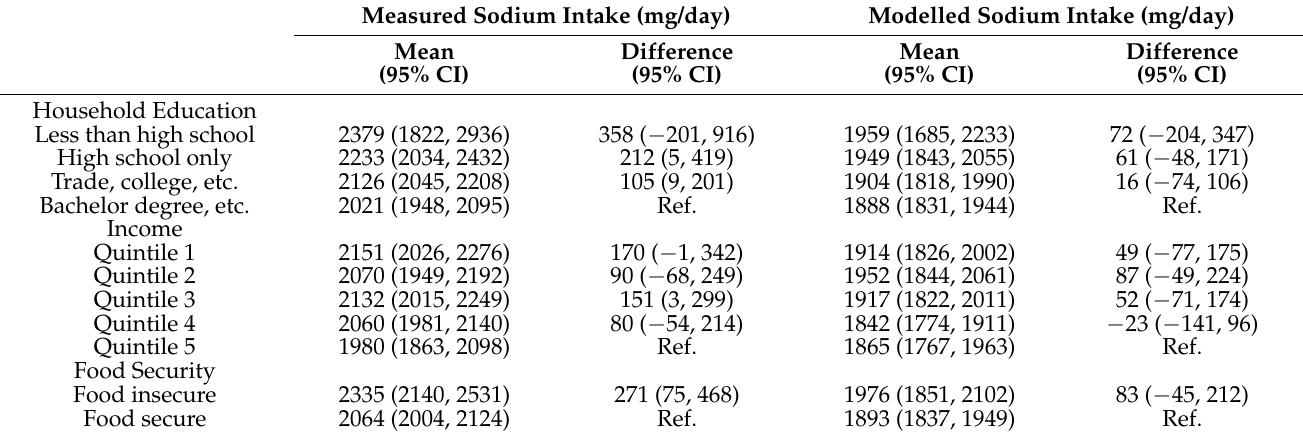
Table 2. Adjusted mean sodium intake and mean differences by socioeconomic position as measured and modelled full compliance to Health Canada’s voluntary Sodium Reduction Guidance (SRG) targets in children 2 to 8 years old in the 2015 Canadian Community Health Survey—Nutrition ( n =